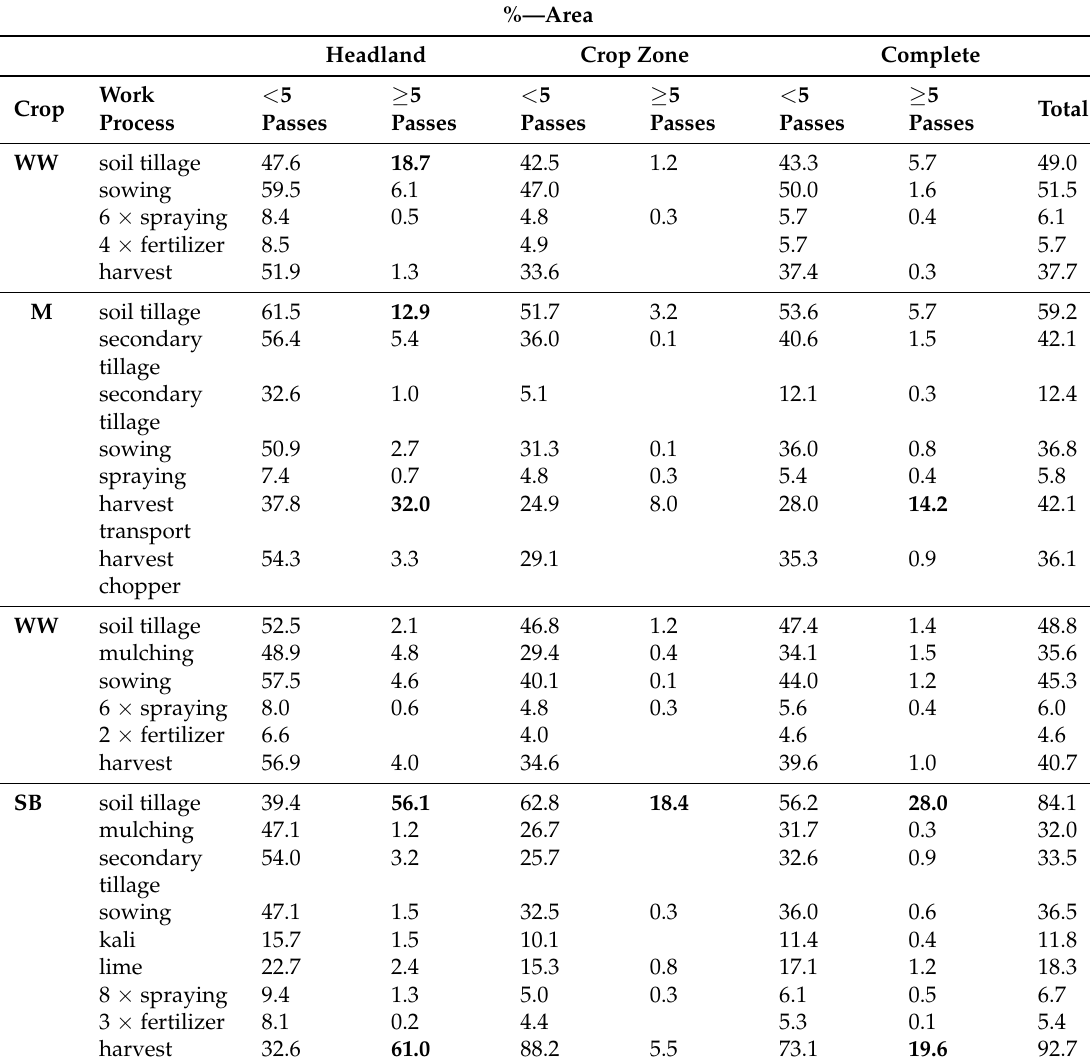
Table 2. Area percentage of the field for single work processes with under and over five wheel passes. In bold are the area shares above